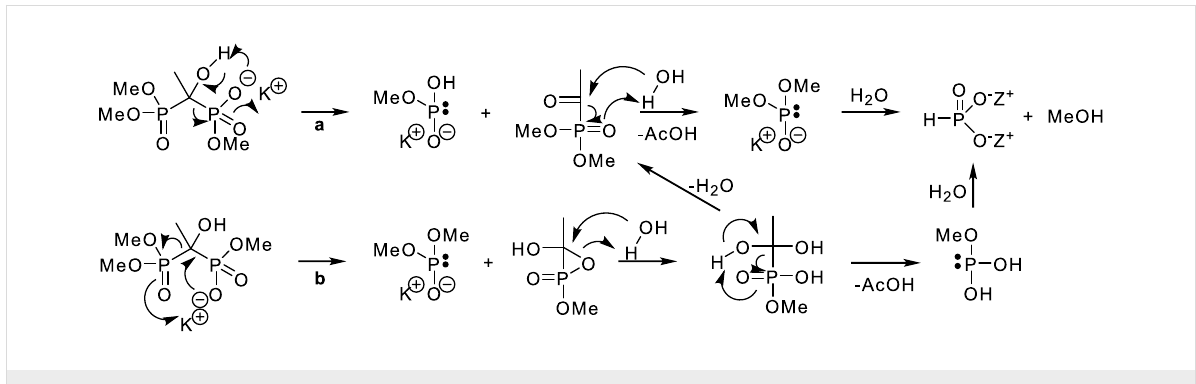
Scheme 3: Proposed reaction mechanism for 1b decomposition.